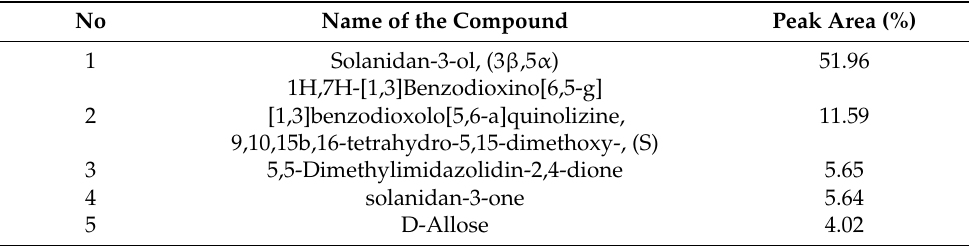
Figure 11. Molecular structure of Solanidan-3-ol, (3 β ,5 α ). Table 4. Main compounds of SCE s analyzed by GC/MS.